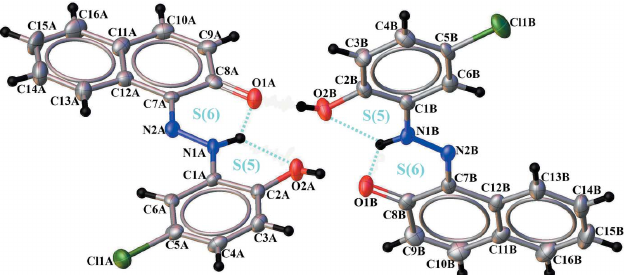
Figure 1 View of the two independent molecules of the title compound, showing the atom-labelling scheme. Displacement ellipsoids are drawn at the 50% probability level. Intramolecular hydrogen bonds are shown as dashed lines.